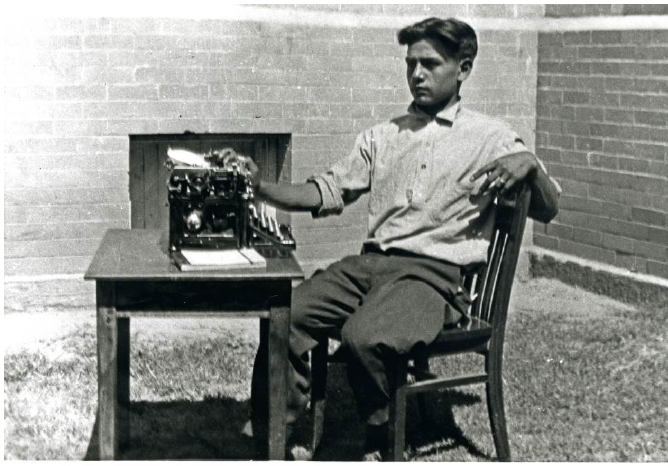
Figure 13. Parker McKenzie, Kiowa, at Main Building. 1916. Parker McKenzie Collection, Courtesy of the Oklahoma Historical